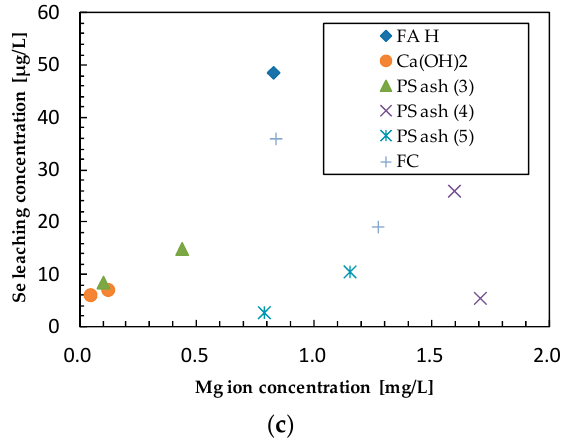
Figure A2. Relationship between the Mg ion leaching concentration and trace elements leaching concentration of five kinds of additives: ( a ) arsenic; ( b ) boron; and ( c ) selenium.